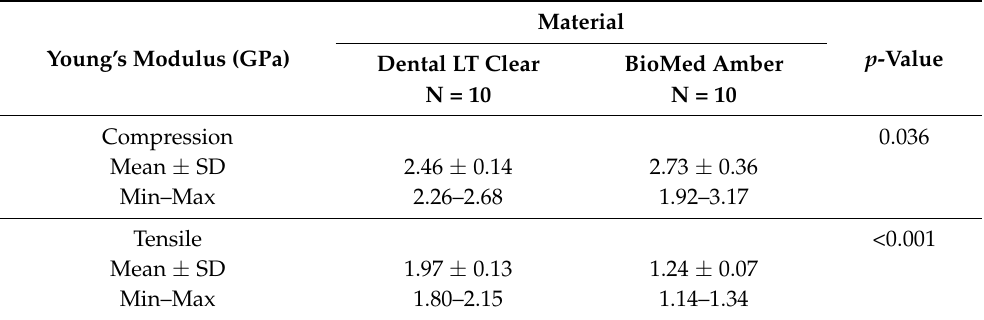
Table 2. Basic statistics of the mechanical properties of the dental materials (Dental LT Clear and BioMed Amber).